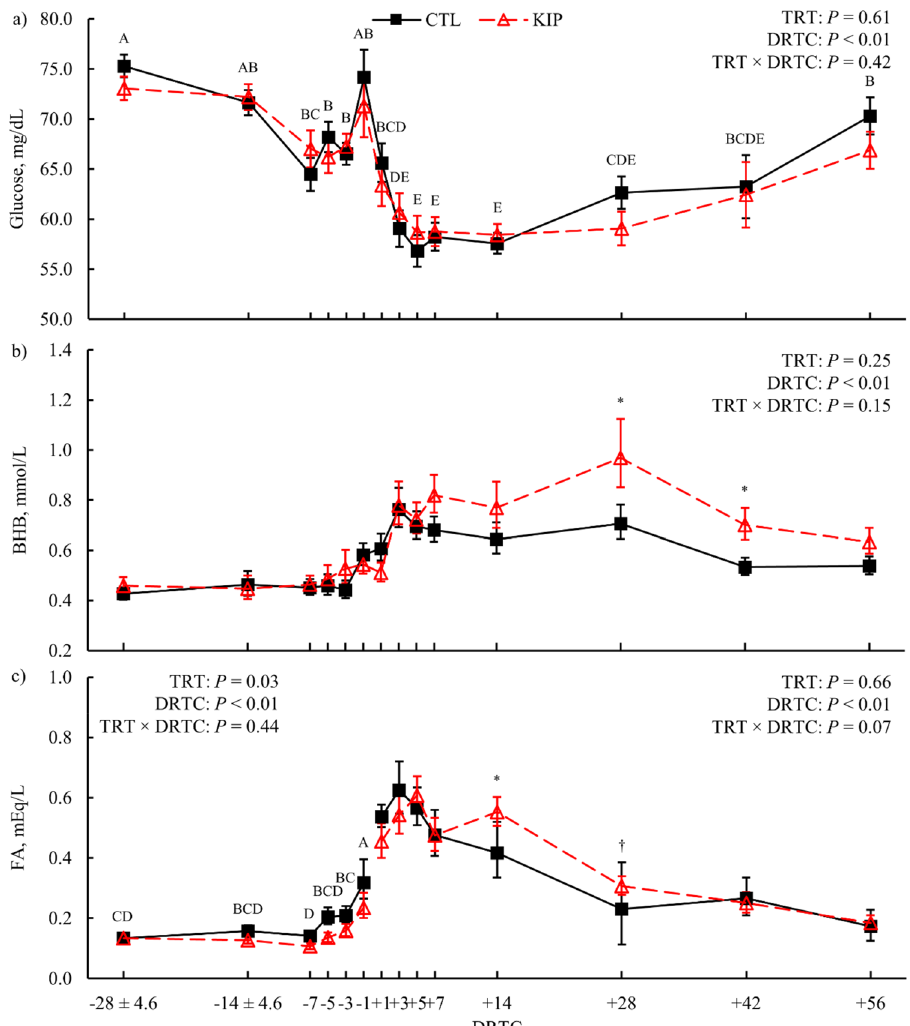
Figure 3. Plasma glucose ( a ), serum β-hydroxybutyrate (BHB; b ), and plasma fatty acids (FA; c ) during the experimental period for control (CTL) and ketosis induction protocol (KIP) treatments (TRT). Variance in the actual DRTC sampled is represented for the relevant prepartum timepoints (± standard deviation). Error bars represent the 68% confidence limits of the least squares mean. Differences across days relative to calving (DRTC, P ≤ 0.05, Tukey’s adjustment) are indicated when alphabetic superscripts do not share characters. Symbols represent significant (* P ≤ 0.05) and marginal ( † 0.05 < P ≤ 0.10) simple effect differences for treatment by time interactions after multiplicity correction